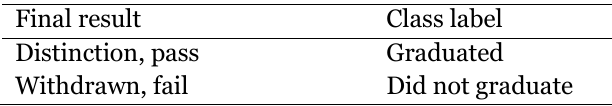
Assignment of Class Labels to the Final